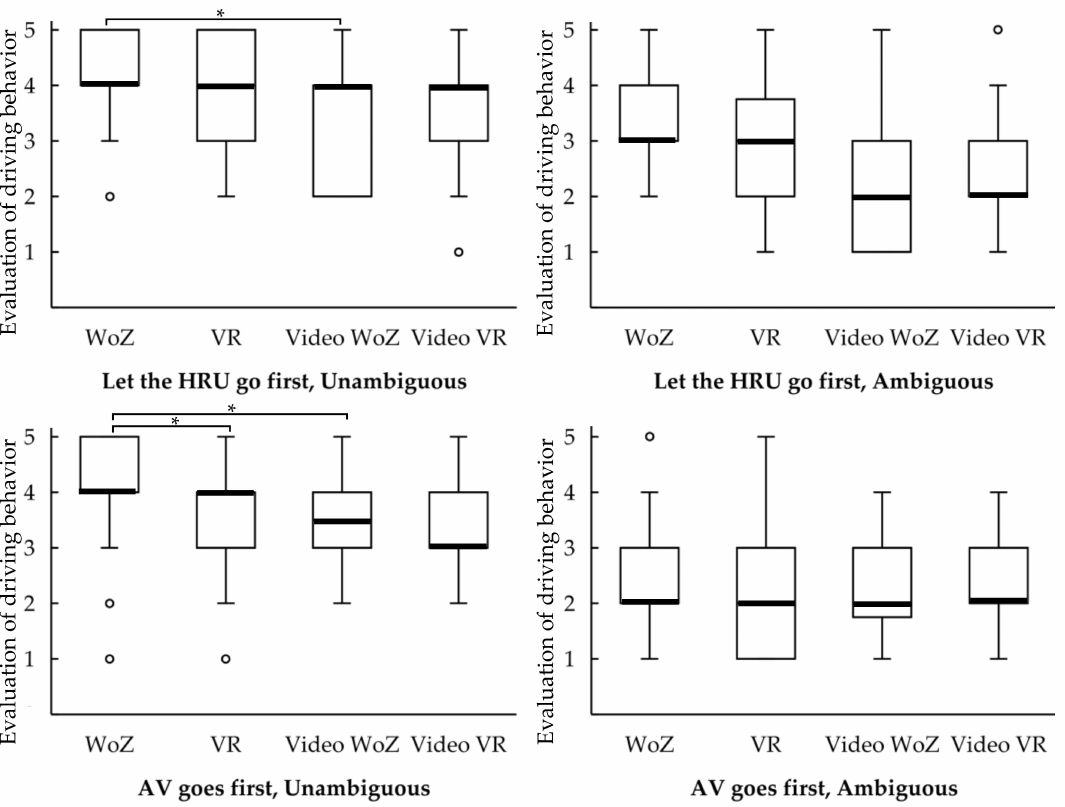
Figure 10. Boxplots for evaluation of driving behavior (1 = very poor, 5 = very good), segregated by setup (* = p < 0.0125).[M1]